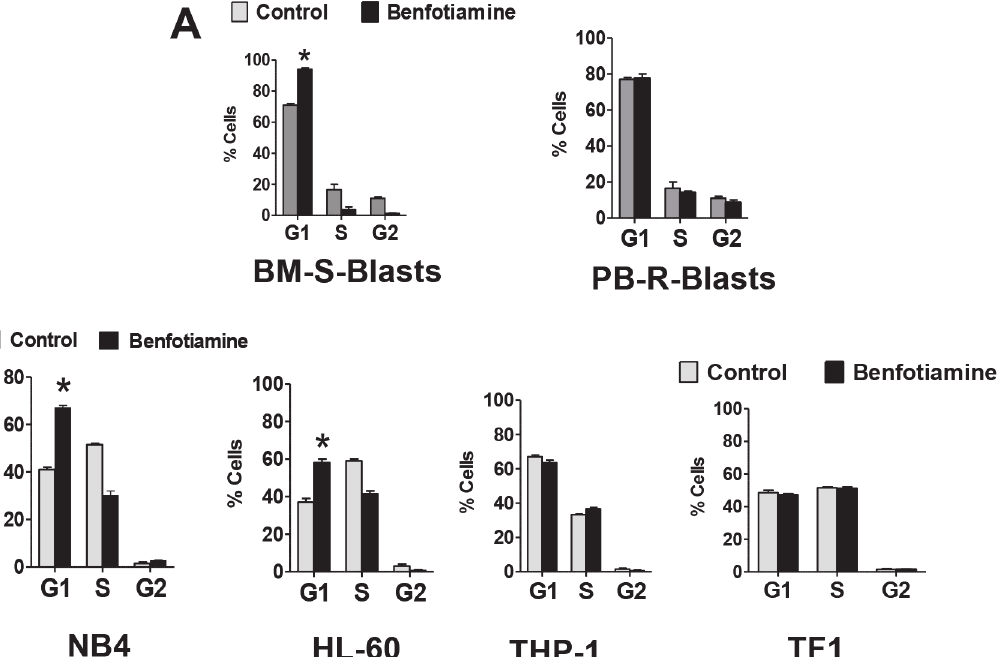
Fig 4. Effects of benfotiamine on cell cycle progression. BM-S-blasts and PB-R-blasts (A) or HL-60, NB4, THP1 and TF1 cells (B) were cultured for 24 hours in the presence or absence of benfotiamine (100 μ M) and the percentages of cells in G 1 , S, and G 2 phases were evaluated by flow cytometry. The figures indicate the means ± SD of summarized data from three independent